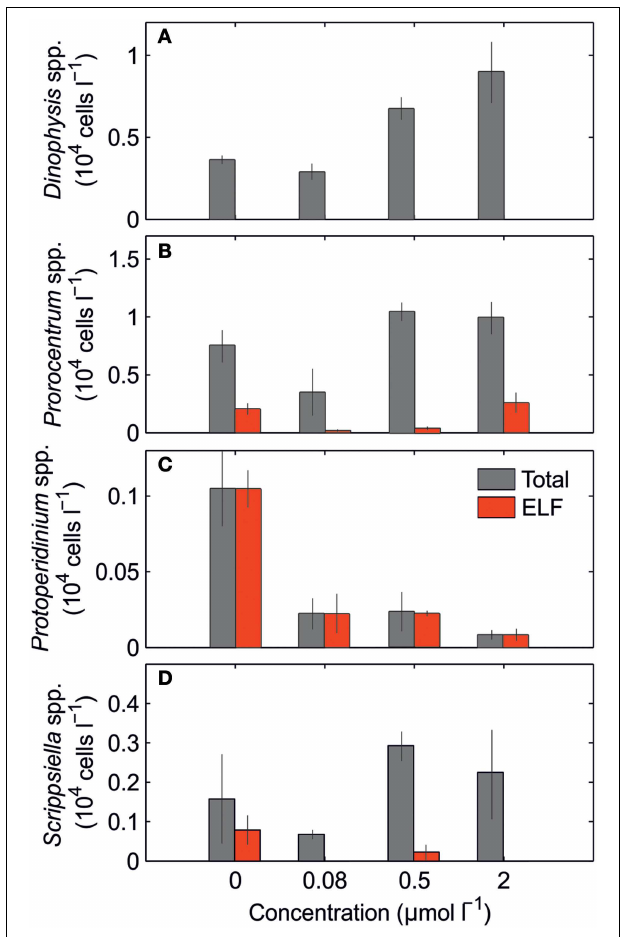
FIGURE 7 | Mean ( ± S.D.) total and ELF-labeled cells abundance (10 4 cells l − 1 ) of (A) Dinophysis spp., (B) Prorocentrum spp., (C) Protoperidinium spp., and (D) Scrippsiella spp. after 3 days of incubation for the control and P i enriched